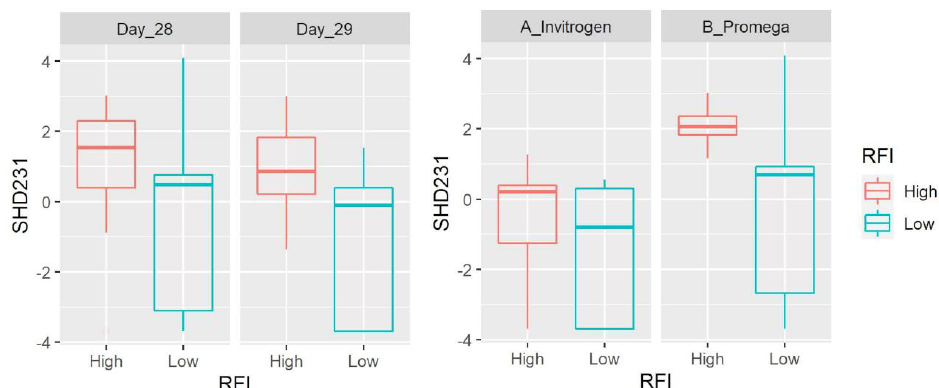
Figure 3. Box plots showing the abundance of SHD-231 (family Anaerolinaceae, Chloroflexi) based